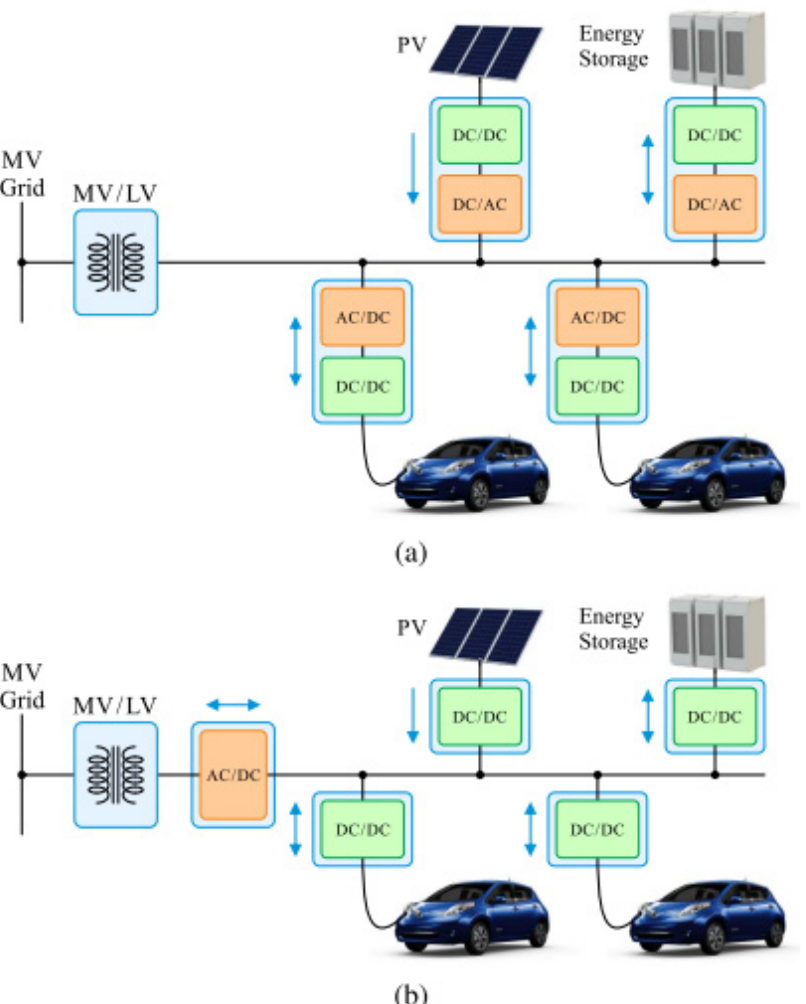
Figure 5. The structure of a DCFC station: ( a ) with AC distribution network ( b ) with DC distribution network where a solid ‐ state transformer may be used instead. (Reprinted with permission from Ref. [6]. Copyright 2019 IEEE.)